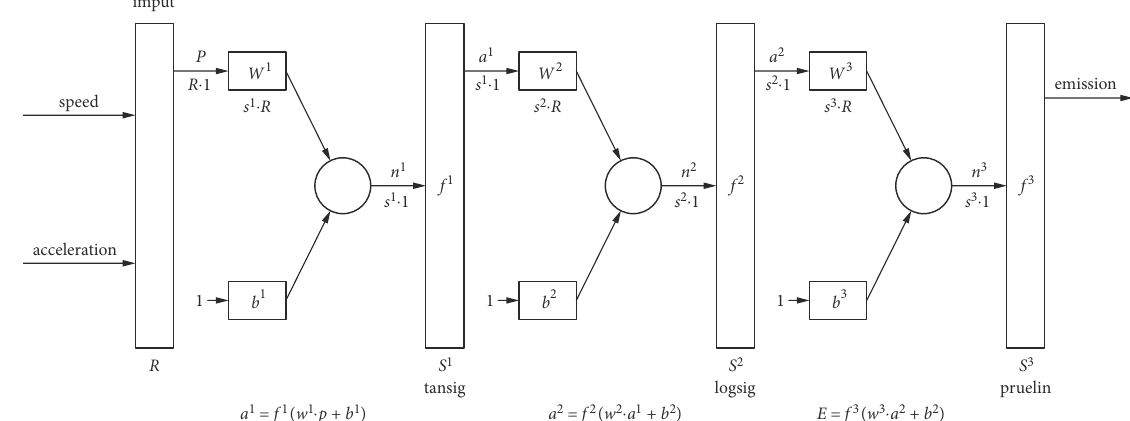
Figure 12. Structure of neural network